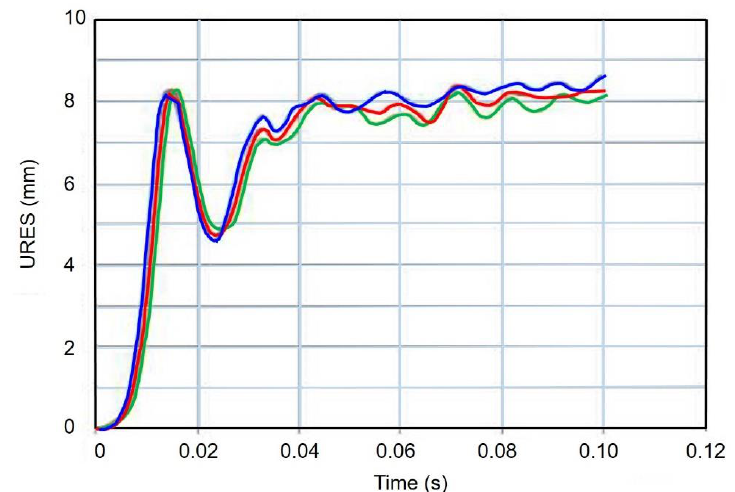
Figure 11. Displacement in characteristic B node [24].